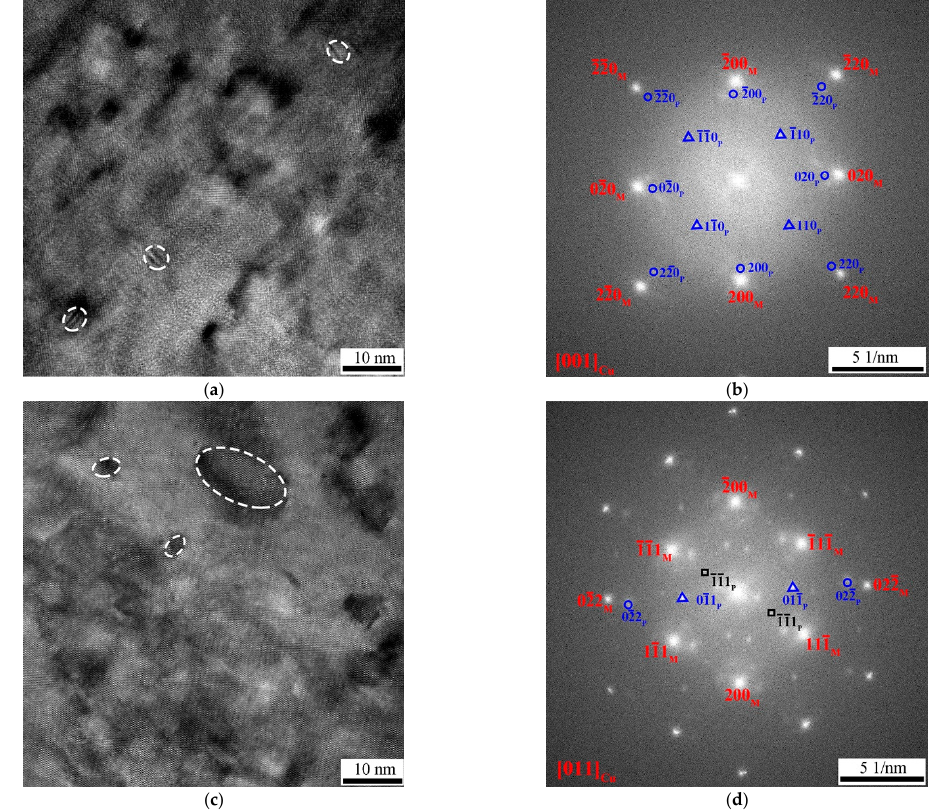
Figure 6. ( a ) An HRTEM micrograph of aged Cu-0.4Cr-0.4Hf-S2 along the [001] Cu zone axis; ( b ) the corresponding FFT patterns of ( a ); ( c ) an HRTEM micrograph of aged Cu-0.4Cr-0.4Hf-S2 along the [011] Cu zone axis; ( d ) the corresponding FFT patterns of ( c ). Some precipitates are marked by ellipses in ( a ) and ( c ).